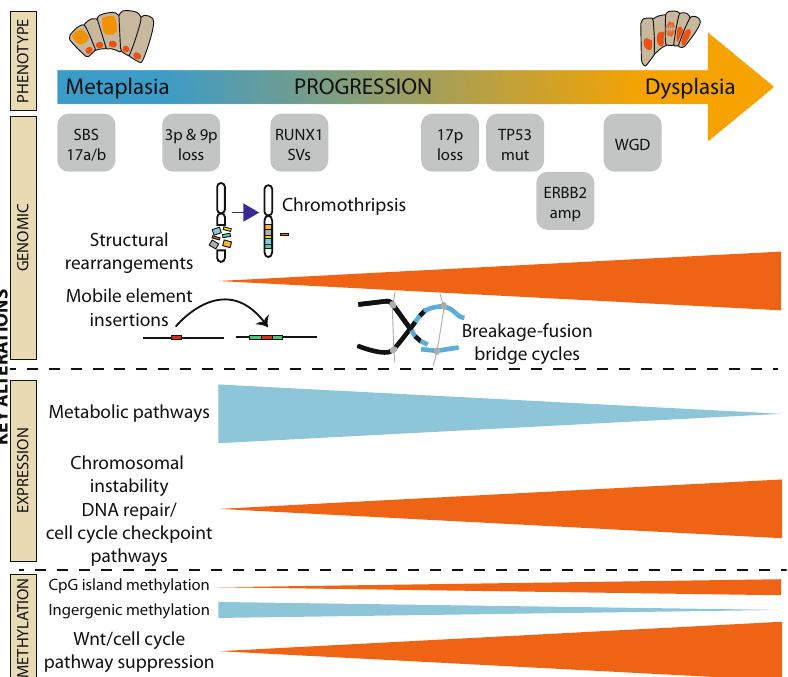
Fig. 8 Summary of main events. Overview of the main events across the different sequencing modalities, seen to be associated with progression from the indolent, non-dysplastic to the dysplastic